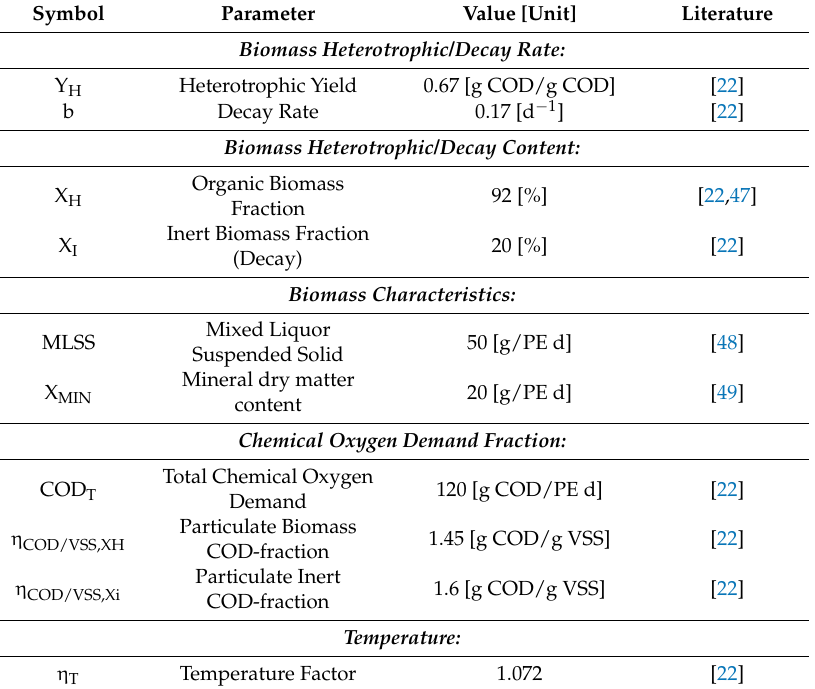
Table 4. Parameter estimation for AS systems in municipal